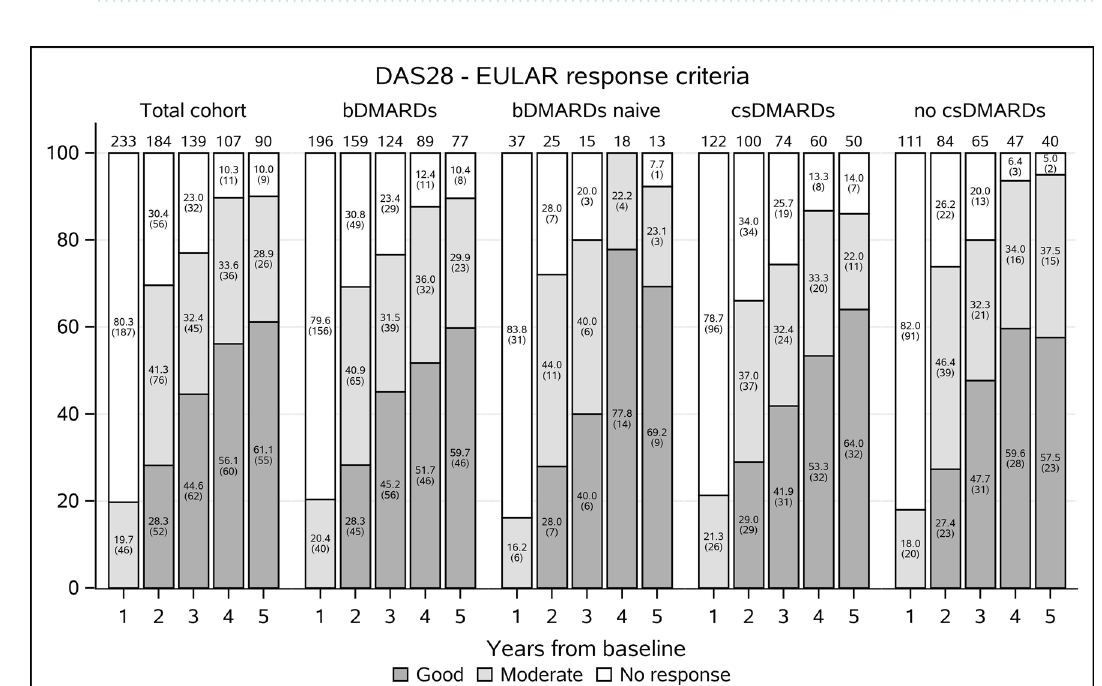
Figure 1. The percentage of rheumatoid arthritis patients treated with reference rituximab with no response, moderate response and good response as defined by EUALR response criteria 13 throughout the 5-year follow-up period. Data are shown for the whole cohort and for patients stratified according to previous or no previous use of biologic treatment and for concomitant and nonconcomitant use of csDMARDs. No significant difference was found between the